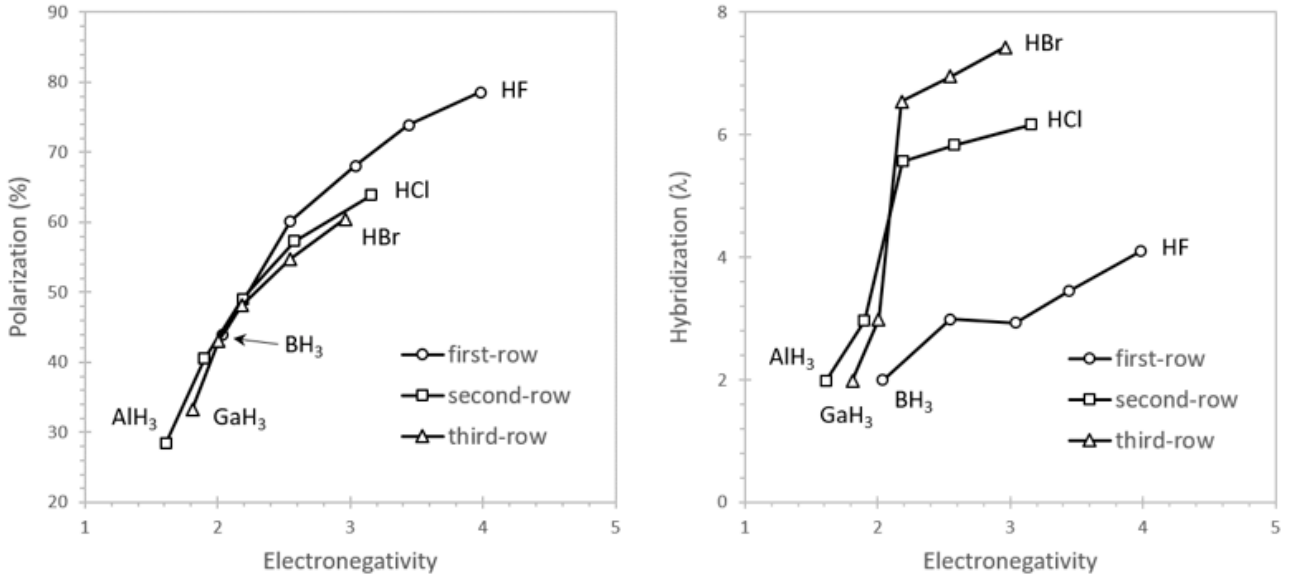
Figure 2. Polarization ( c X 2 ) and hybridization ( λ ) of the X–H bonds of normal-valent hydrides as a function of the Pauling electronegativity of the main group atom (MP2/aVTZ).